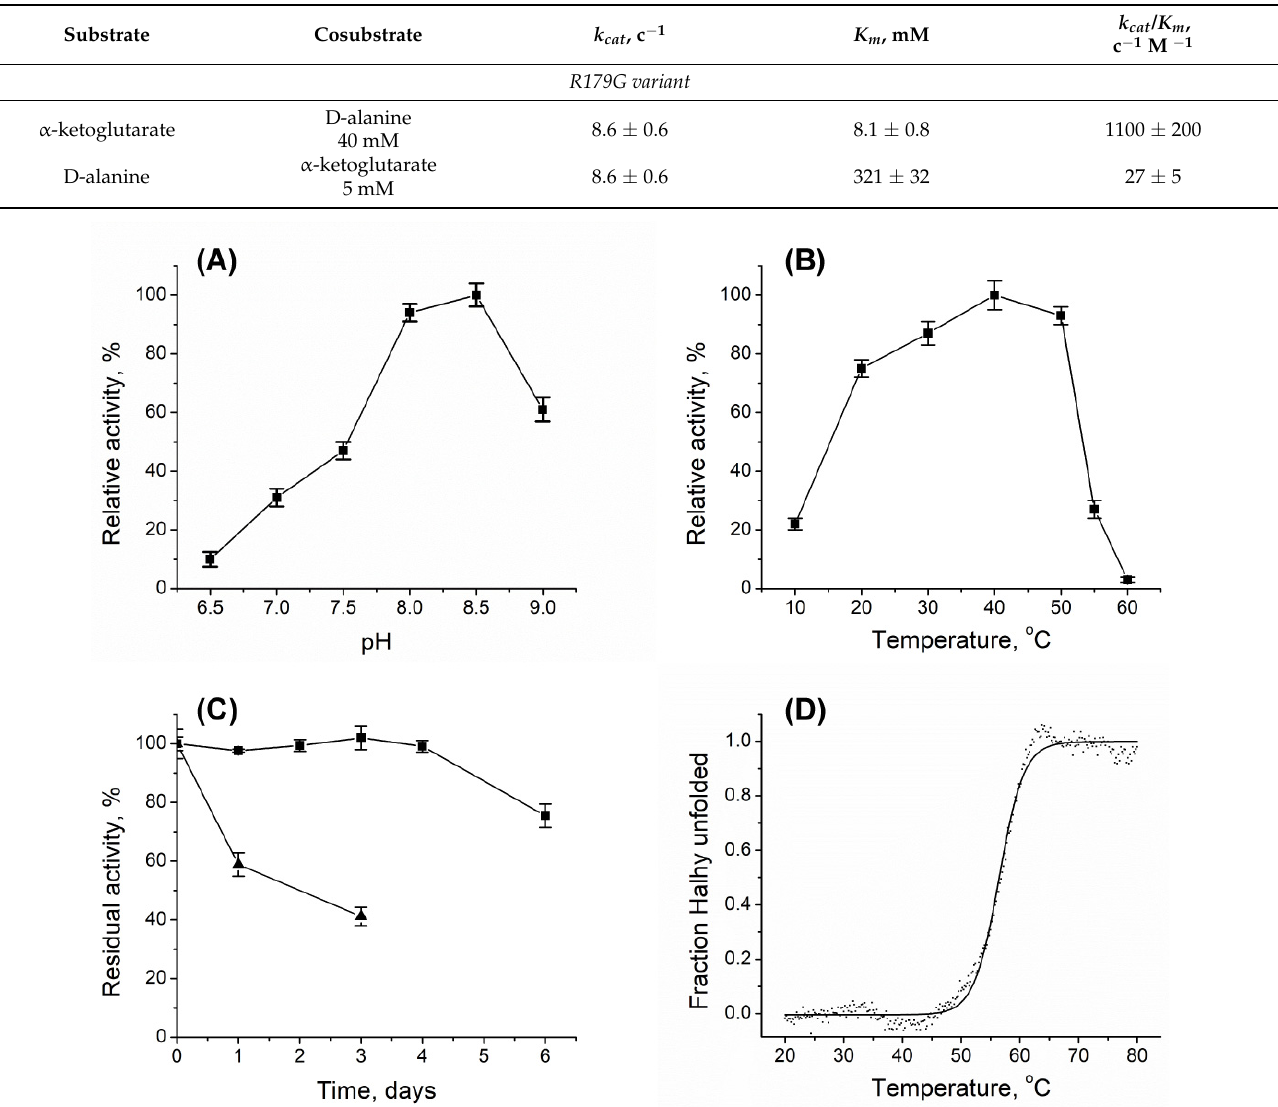
Figure 1. Kinetic and thermodynamic stability of WT Halhy. ( A , B ) the effects of pH and temperature on the overall transamination reaction with D-alanine and α -ketoglutarate; 100% corresponds to 27 ± 2 U/mg ( A ) and 50 ± 3 U/mg ( B ). ( C ) The residual activity of Halhy incubating at 40 °C ( ■ ) and 50 °C ( ▲ ): 100% corresponds to 50 ± 3 U/mg in the standard assay. Error bars represent standard deviation. ( D ) Thermal unfolding in K-phosphate buffer, pH 8.0.